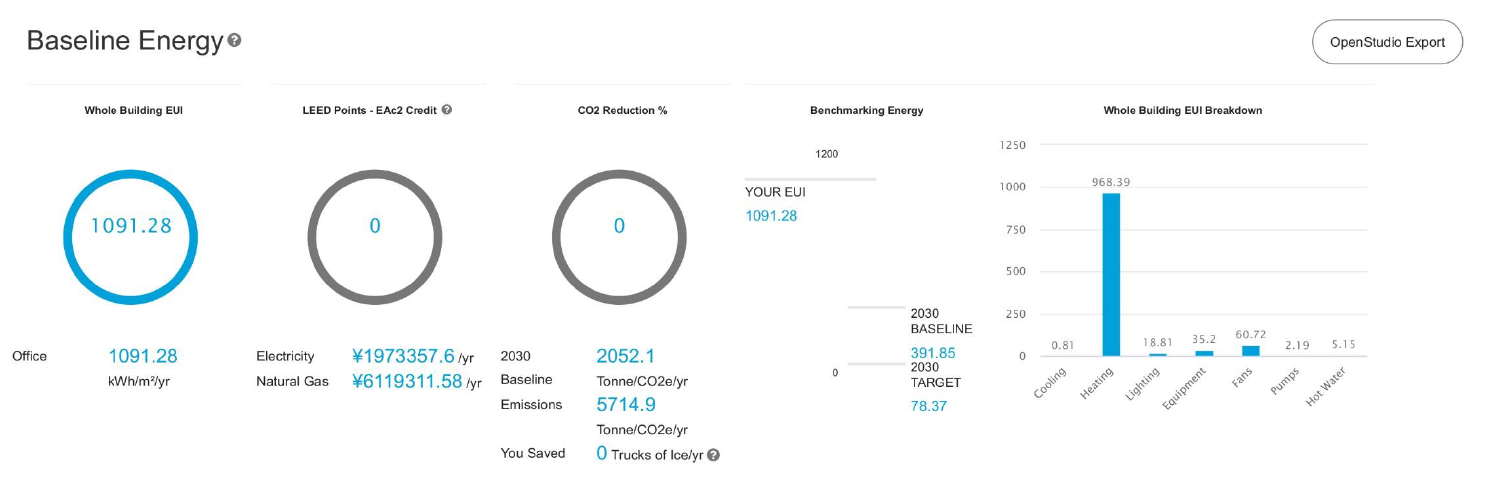
Figure A46. Zone 8 Tahé, Heilongjiang (pre-COVID-19 scenario).